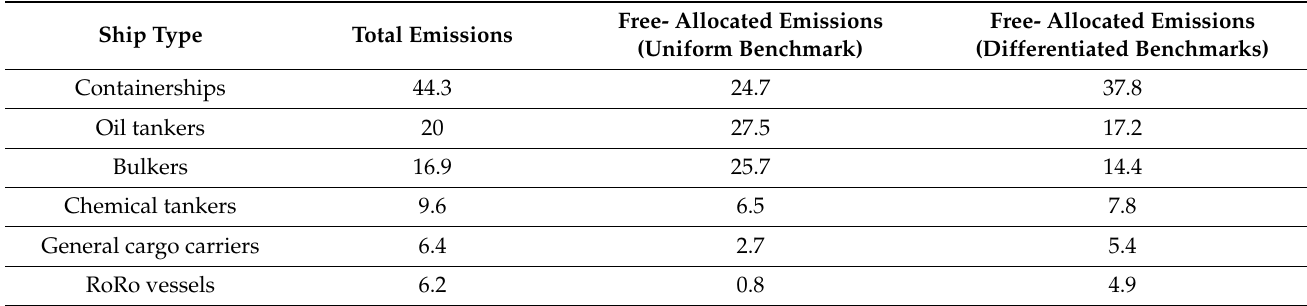
Table 2. CO 2 emissions free-allocated on the basis of a uniform/differentiated benchmarks for all maritime segments